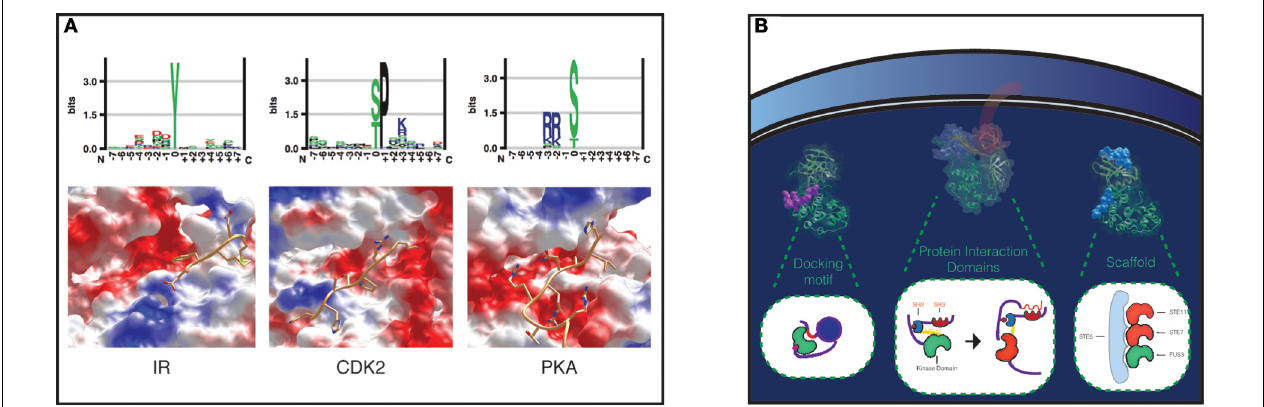
FIGURE 1 | Specificity levels in Protein Phosphorylation. (A) Peptide specificity in a tyrosine kinase, Insulin Receptor (IR), a proline-directed kinase, Cyclin-dependent kinase 2 (CDK2), and a serine threonine kinase, cAMP-dependent protein kinase catalytic subunit alpha (PKA). Peptide preferences for each kinase are represented as sequence logos (top). The binding pockets of the three kinases have been visualized with UCSF Chimera, and the surfaces colored according to their electrostatic potential: red, positive; blue, negative; white, neutral (bottom). The structures from left to right show IR in complex with a peptide (pdb 1IR3), CDK2 in complex with a substrate peptide and cyclin A (pdb 1QMZ), which contributes to